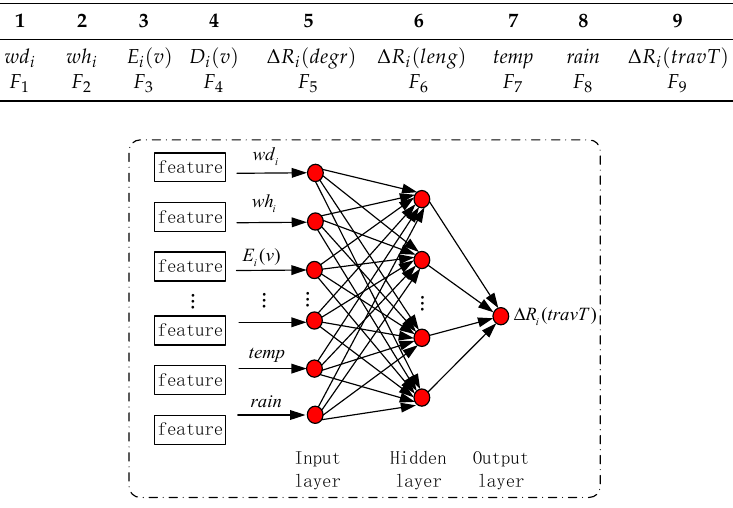
Figure 5. Model structure of BP neural network. wd i , day of the week; wh i , the 30 min during a day; E i ( v ) , expected speed; temp , temperature; rain , rainfall; ∆ R i ( travT ) , travel time ratio between a target link and adjacent links. Arrows in this figure represent input data flow and red points stand for neurons in neural network.